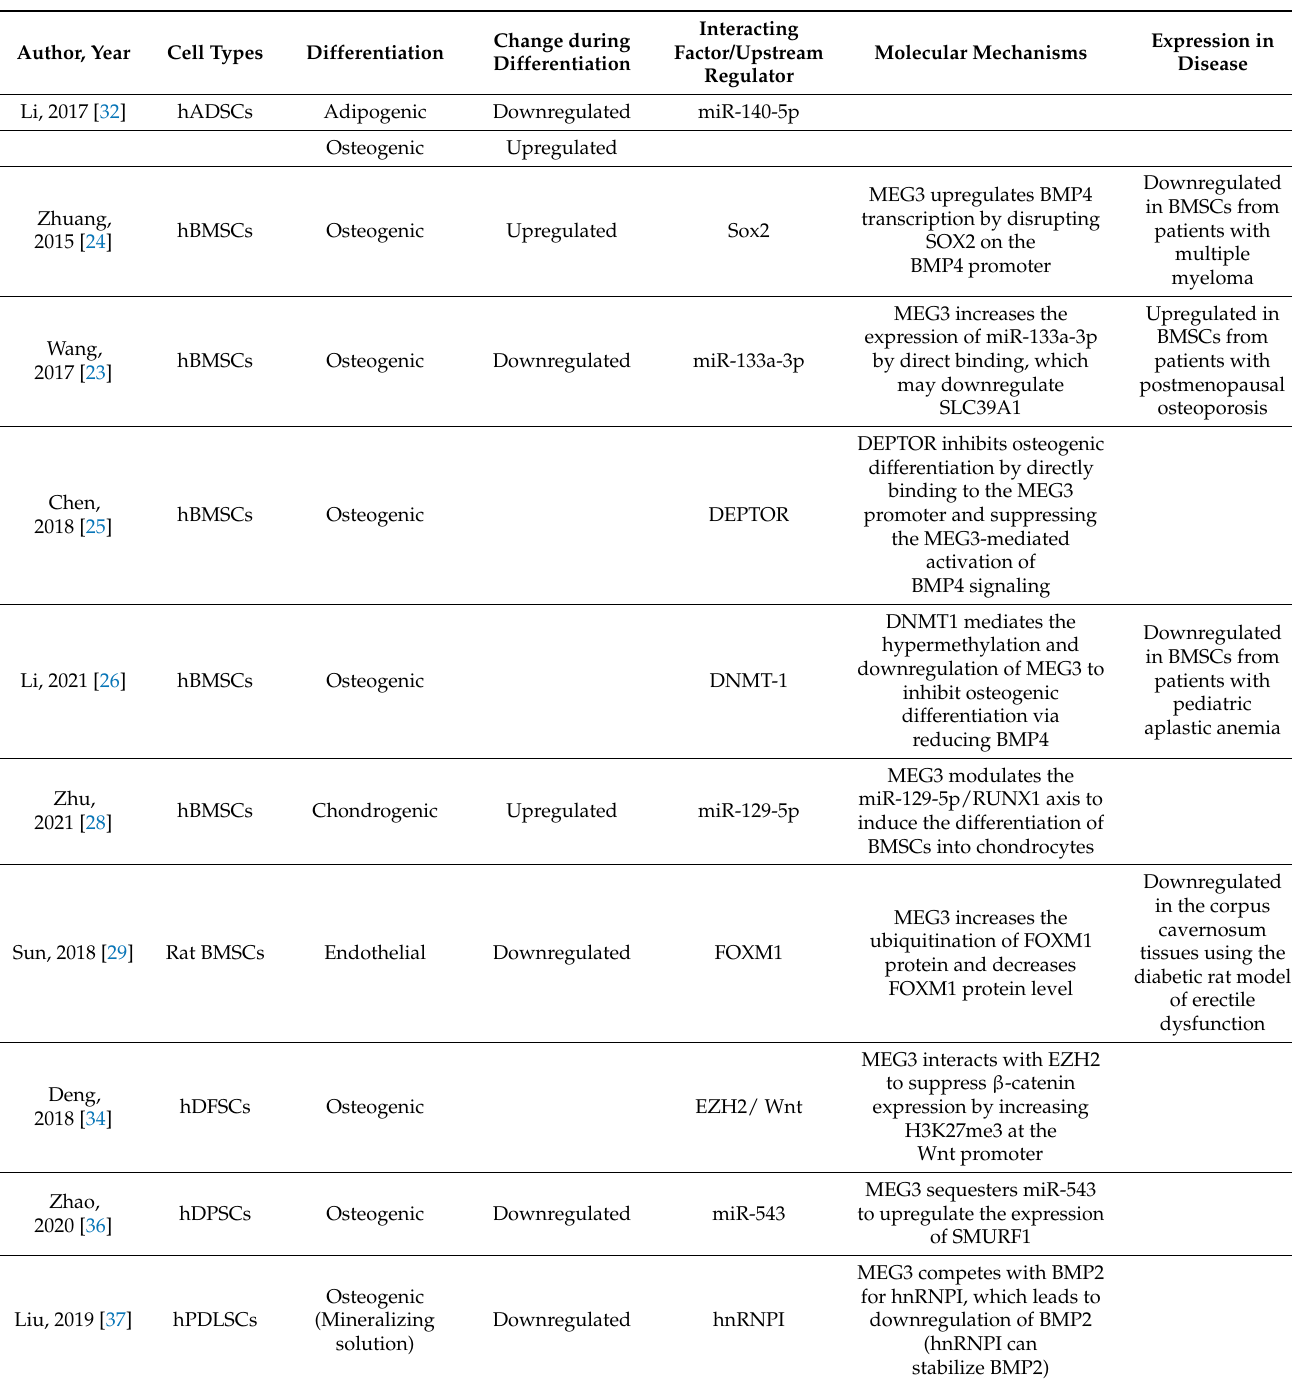
Table 1. The effect of MEG3 on the differentiation of various types of stem